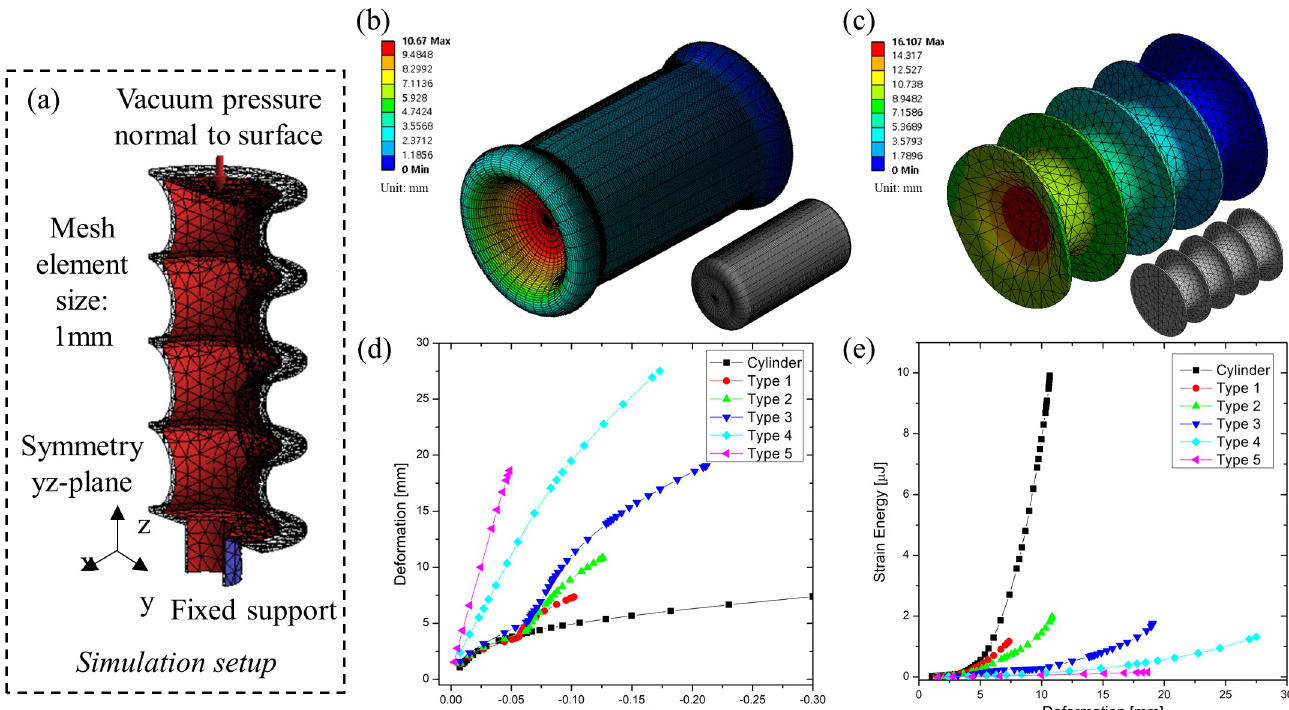
Fig 3. FEM results: a) simulation setup of half structure, where planar symmetry was exploited; (b) deformation of a simple cylindrical skin structure with -0.62 kPa of applied vacuum; c) deformation of bellow Type 3 with -0.21 kPa of applied vacuum; (d) pressure versus deformation graphs for all bellow types; (e) deformation versus strain energy graphs for all bellow types. In (b) and (c): the color legends show deformation values in mm; the gray models show the relative meshes used for the simulations.